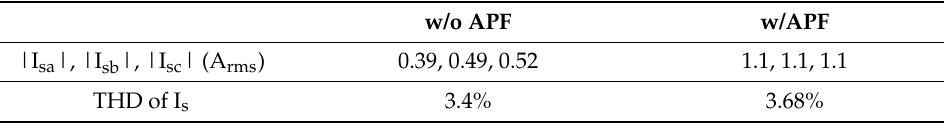
Figure 13. ( a ) v ab-pcc , i sa and i sb without the shunt APF. ( b ) v ab-pcc , i sa and i sb with the shunt APF. (10 ms/div). Table 10. Magnitudes and THD of the source currents.